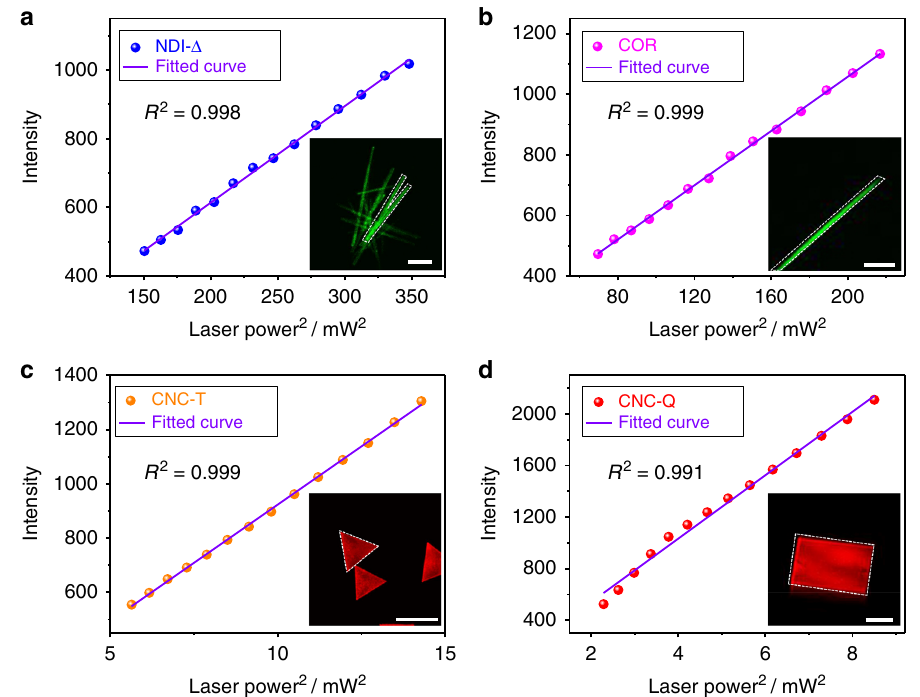
Fig. 7 Excitation power dependence of upconversion fl uorescence intensity. The linear dependence between the upconversion fl uorescence intensity and the square of the excitation laser power for a NDI- Δ excited at 740 nm, b COR excited at 740 nm, c CNC-T excited at 1000 nm and d CNC-Q excited at 1000 nm. The upconversion fl uorescence intensity of each material was collected from the marked region in the inset two-photon microscopy image. Scale bars: 20 μ m in ( a , b , d ), 50 μ m in ( c ).